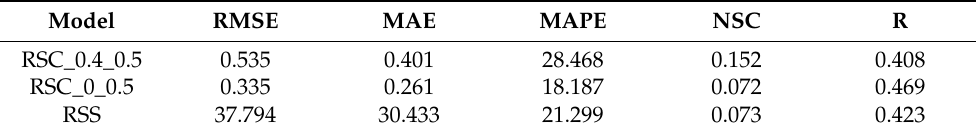
Table 3. Error metrics of multiple linear regression models.